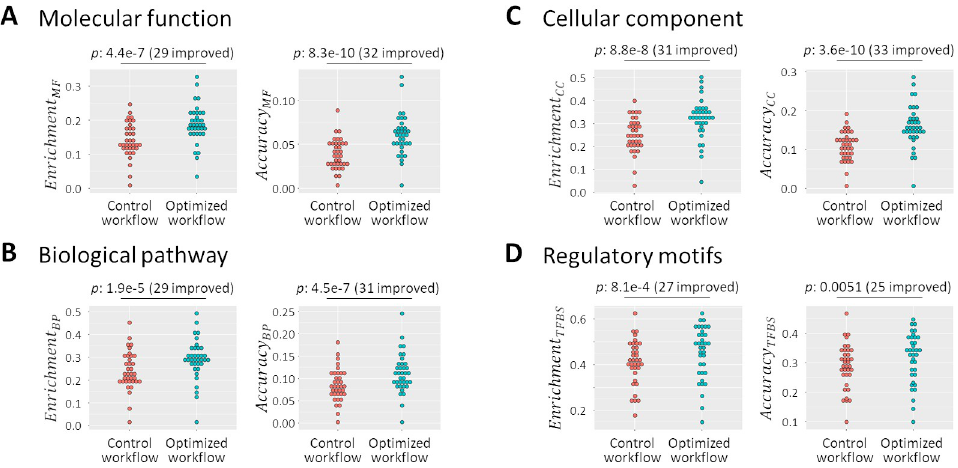
Fig 6. Optimized workflows lead to a significant improvement in all eight quality measures. (A-D) (left) Dotplots showing the fraction of genes with enrichment of GO terms and regulatory motifs in networks produced by a default workflow (red) and the optimized workflow (blue). (right) Dotplots showing the fraction of genes with an annotation that fit with enrichment GO terms, and with promoters that contain an instance of an enriched regulatory motif. Each dot represents one of the 36 (17 human and 19 mouse cell types and tissues) validation datasets. P-values are based on one-sided paired t-tests. The number of validation datasets in which an improvement was observed is indicated between